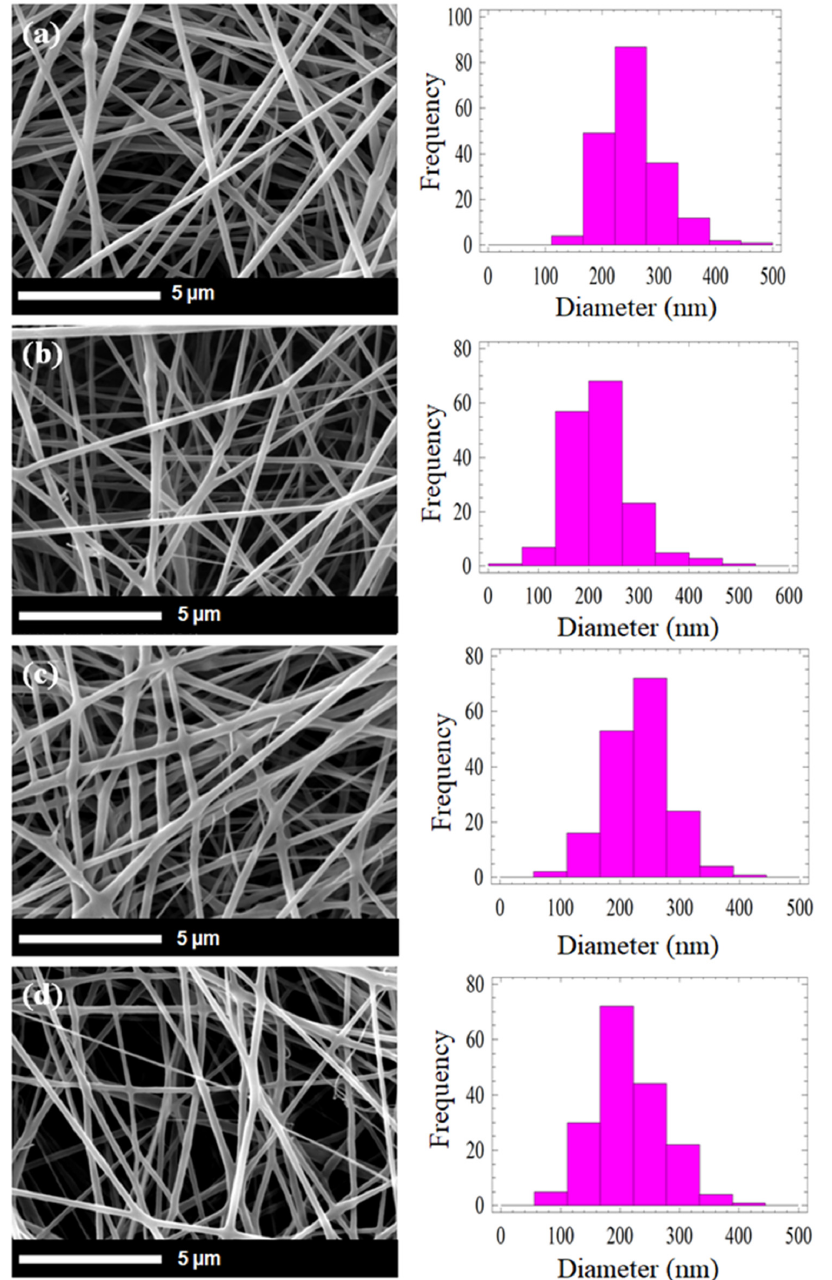
Figure 1. SEM micrographs of the morphology and fiber diameter distribution of PLLA / CMS / β -TCP irradiated at different irradiation doses ( a ) non-irradiated; ( b ) 5, ( c ) 30 and ( d ) 100 kGy.